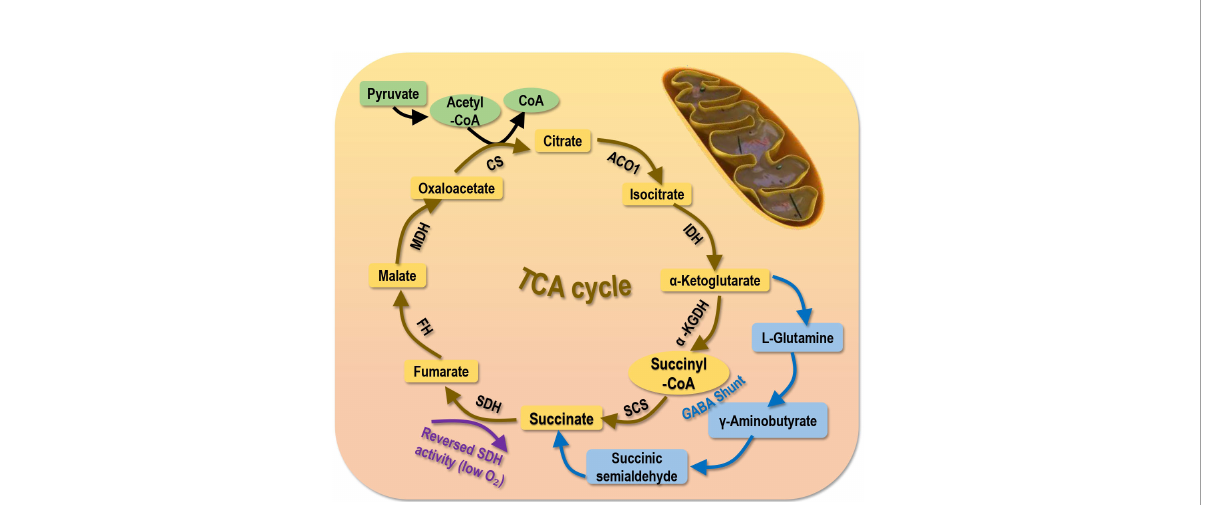
FIGURE 3 Primary sources generating succinate. Succinate is primarily generated from the tricarboxylic acid (TCA) cycle. Succinate can also be produced via the g -Aminobutyric acid (GABA) shunt or under low oxygen supply that reverses the activity of SDH. SCS, succinyl-CoA synthetase; SDH, succinic dehydrogenase; a-KGDH, a-ketoglutarate dehydrogenase; IDH, isocitrate dehydrogenase; ACO1, aconitase ; CS, citrate synthase ; MDH, malate dehydrogenase ; FDH, famarate dehydrogenase ; FH, famarate